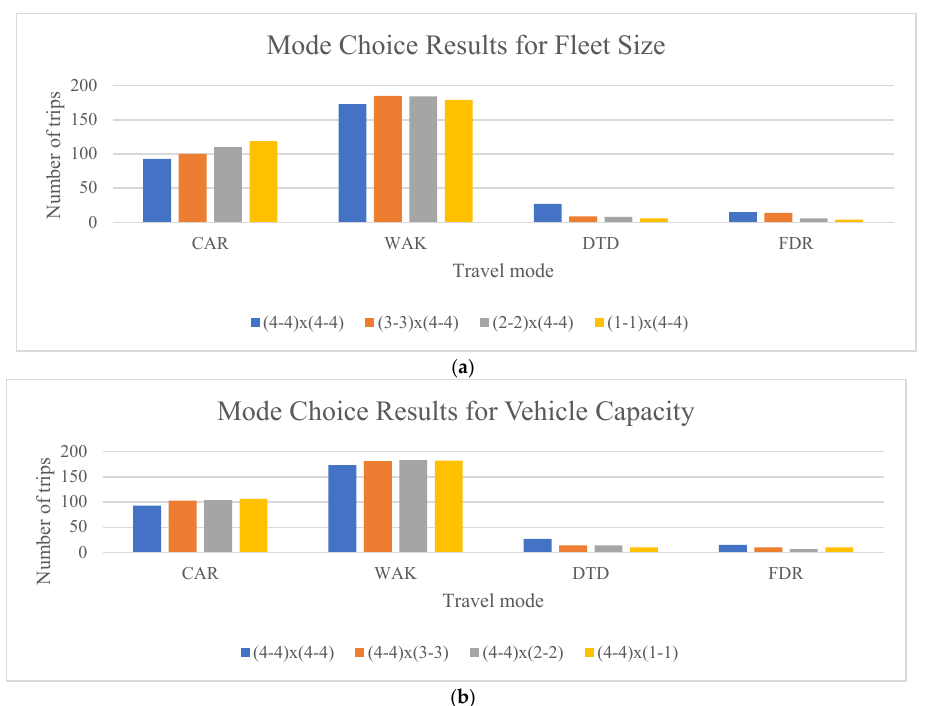
Figure 6. Mode choice results for different fleet sizes ( a ); and vehicle capacities ( b ).